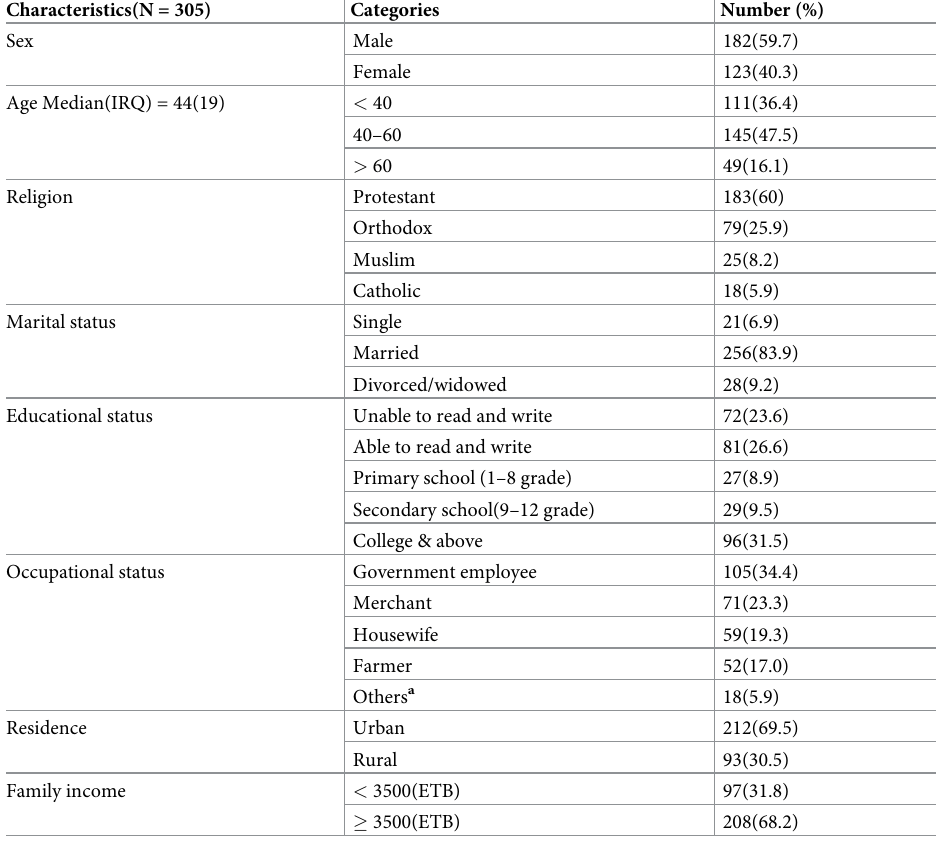
Table 1. Socio-demographic and economic characteristics of the study participants attending diabetic clinic at public hospitals in Hadiya zone, Southern Ethiopia, 2019. Characteristics(N =